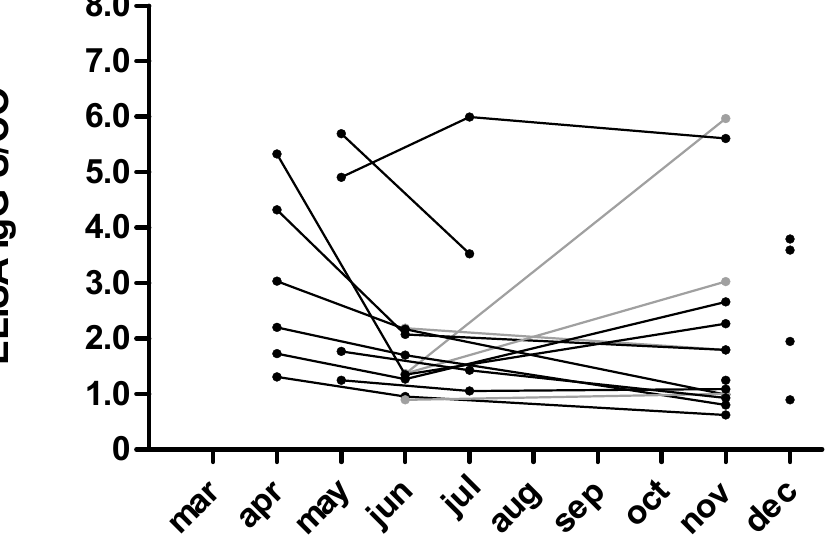
Figure 2. IgG ELISA signal to cutoff (S/CO) in healthcare workers testing positive for SARS-CoV-2 IgG. The black line indicates the follow-up of participants who tested positive for SARS-CoV-2 IgG during the first observational period. The grey lines indicate the follow-up of participants who tested positive during the second observational period. The triangles illustrate the S/CO’s of participants who tested positive within the third observational period.